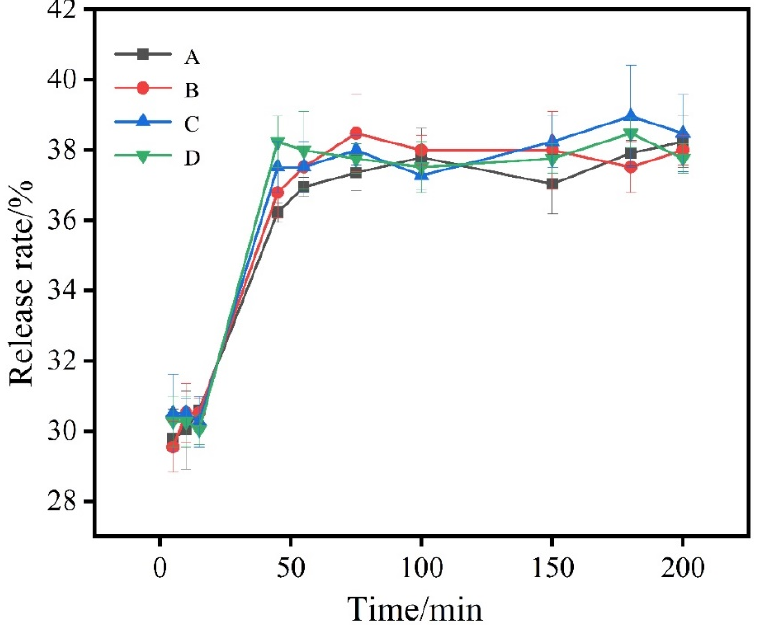
Figure 6. Release curves of (A) group A microcapsules; (B) group B microcapsules; (C) group C microcapsules; and (D) group D microcapsules in 50% ethanol solution.